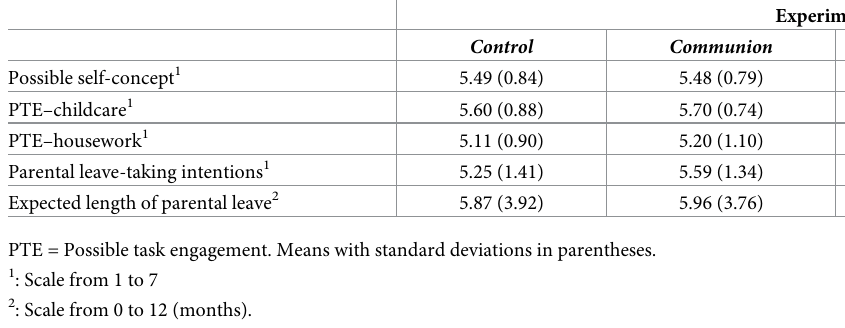
Table 5. Means and standard deviations for possible selves and parental leave outcomes in experimental conditions (Experiment